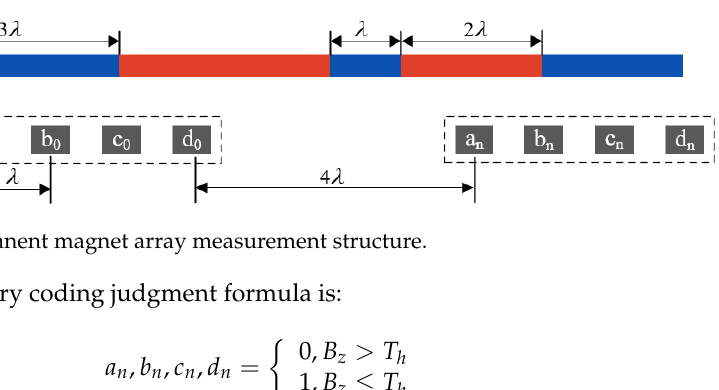
Figure 5. C oded permanent magnet array measurement structure.